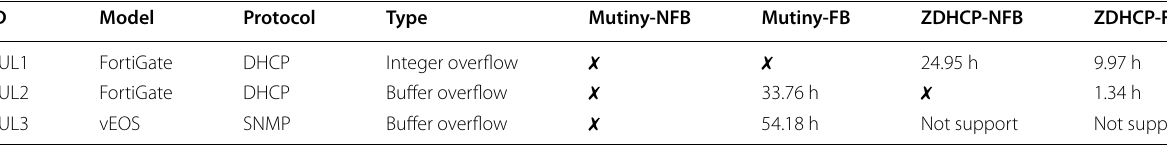
Table 5 Unique crashes statistic